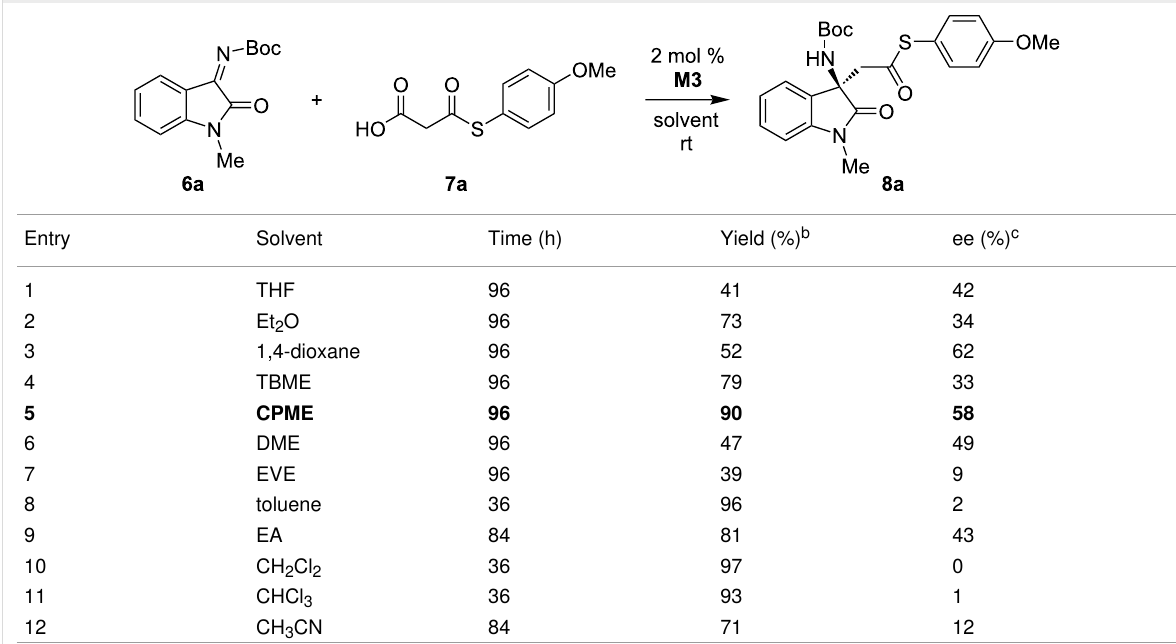
Table 2: Evaluation of solvents a .